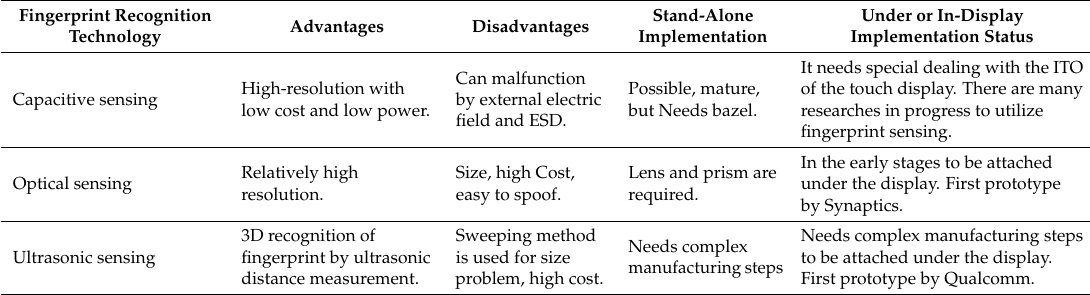
Table 1. Comparison between the major fingerprint sensing